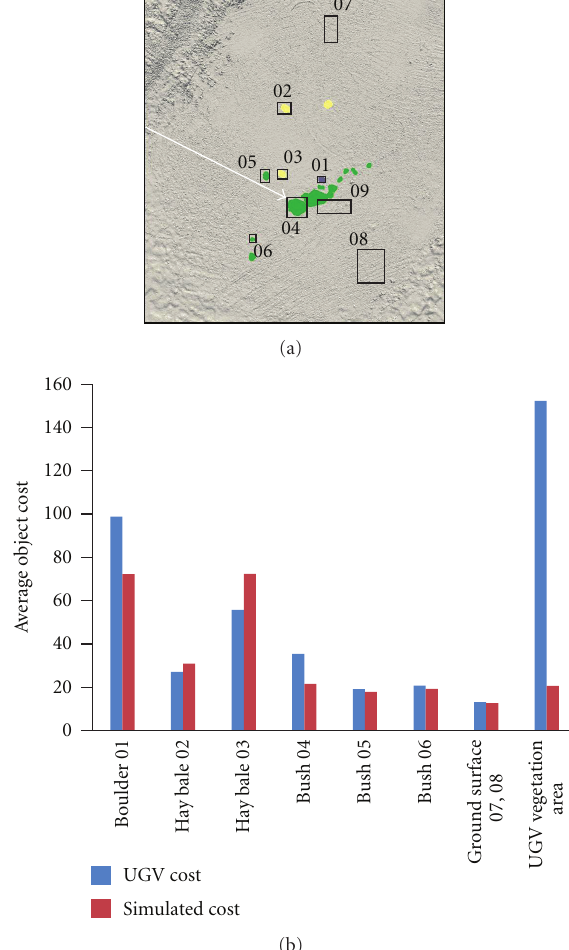
Figure 9: Comparison between simulated and actual costs associ- ated with each object in the scene. On the left is an overhead view of the scene with each object labeled along with the path the UGV traveled. The average cost of each object is very similar between the simulated and ground truth data for the boulder and hay bales, but the area of high cost seen behind the vegetation generated by the true LIDAR data was not reproduced in